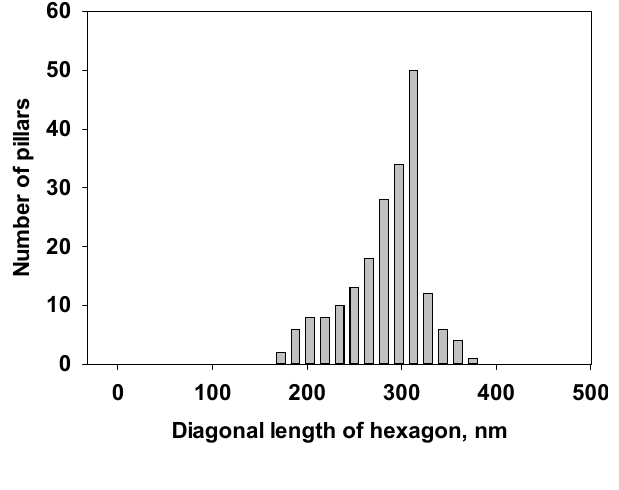
Figure 3. Size distribution of the CA/M pillars prepared from M with CA (both 0.001 M in water) on